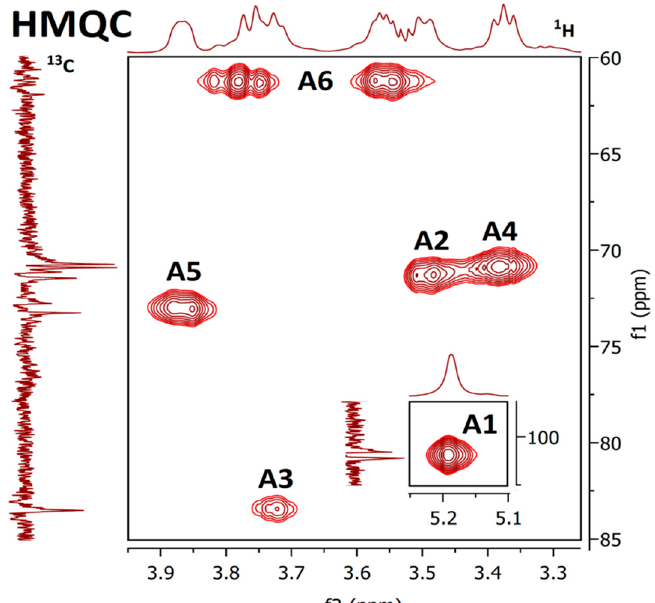
Figure 5. Carbon-13 APT NMR (left) and 1 H, 13 C HMQC (right) spectra of sub-fraction F3a.